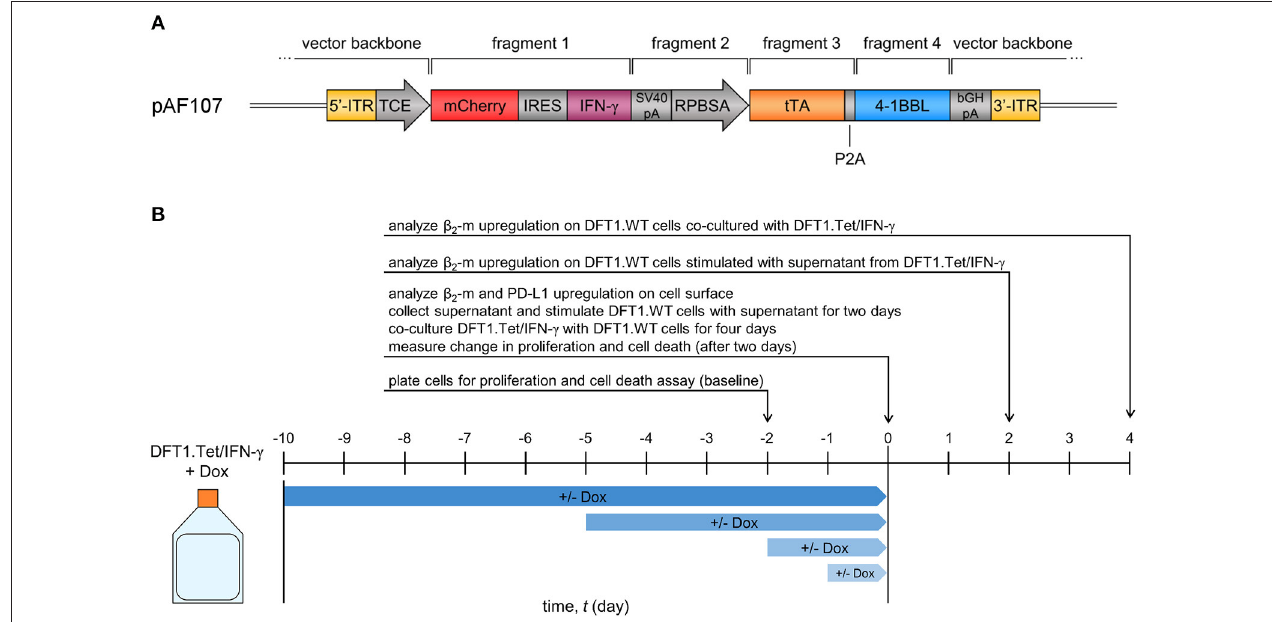
FIGURE 1 | Vector and study design of Tet-inducible IFN- γ -expressing DFT1 cells (DFT1.Tet/IFN- γ ). (A) Expression vector for tetracycline (tet)-controlled inducible IFN- γ expression in DFT1 cells. ITR , inverted terminal repeats; TCE , tet-responsive promoter; IRES , internal ribosomal entry site; tTA , tet-controlled transactivator. (B) Timeline for dox + /– treatments of DFT1.Tet/IFN- γ used in subsequent experiments. DFT1.Tet/IFN- γ cultured in 100ng/ml doxycycline (Dox) was split into four groups with doxycycline removed or doxycycline continually replenished for 1, 2, 5, or 10 days. Cells were analyzed for: (i) surface β 2 -m and PD-L1 upregulation; (ii) ability to stimulate MHC-I upregulation on wild type DFT1 cells (DFT1.WT) using the supernatant or by co-culture; and (iii) cell proliferation and viability in response to doxycycline